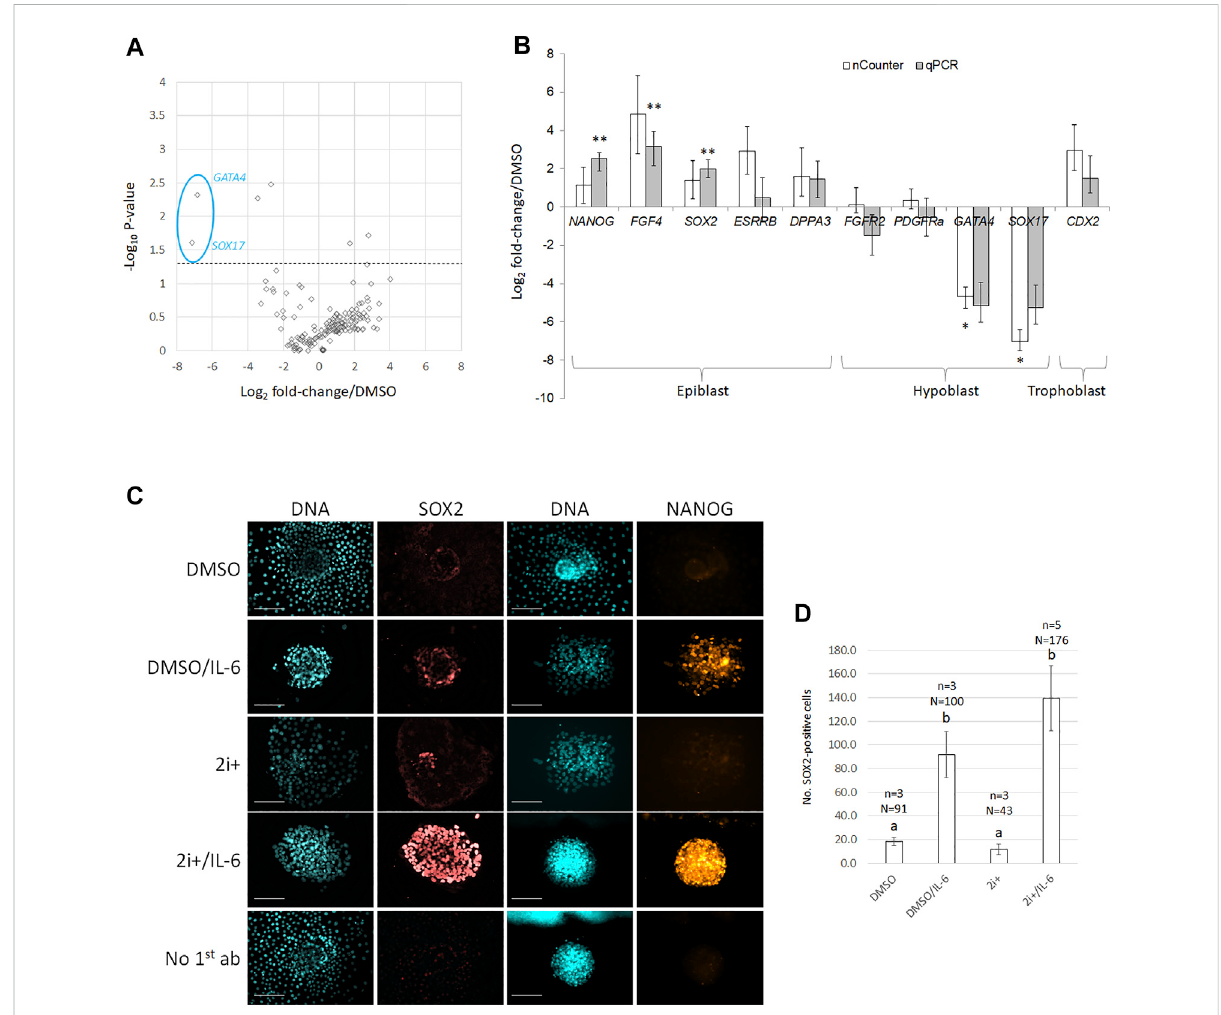
FIGURE 1 2i+/IL-6 reduces hypoblast and increases epiblast marker expression on mRNA and protein levels. (A) Volcano plots of gene expression changes.BiologicalfoldchangeswerenormalizedontheDMSOcontrol.Astippledlineindicates p =0.05fromatwo-tailed t -test. (B) Comparisonof nCounter vs. qRT-PCR analysis for putative lineage-speci fi c marker genes. cDNA was extracted from pools of grade 1 – 2 D8 blastocysts cultured in DMSO- vs. inhibitor-containing medium. Target gene values are expressed as fold change over DMSO control; error bars indicate the mean ± SE of the log ratios of gene expression relative to the DMSO control. * and ** bars differ p < 0.05 and p < 0.01, respectively, from DMSO control. (C) Immuno fl uorescence against pluripotency-related epiblast markers (SOX2 and NANOG) and DNA (Hoechst 33342) on primary ICM